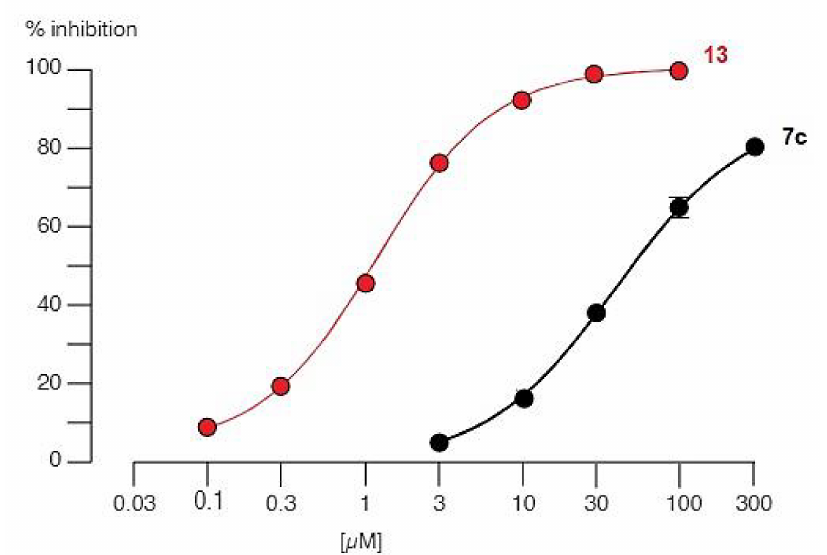
Figure 4. Quantitative analysis of the % inhibition of Panx1-mediated membrane currents in oocytes for compounds 7c and 13 . CBX is not shown because it has the same 100% inhibition as 13 . The error bars in all instances were smaller than the